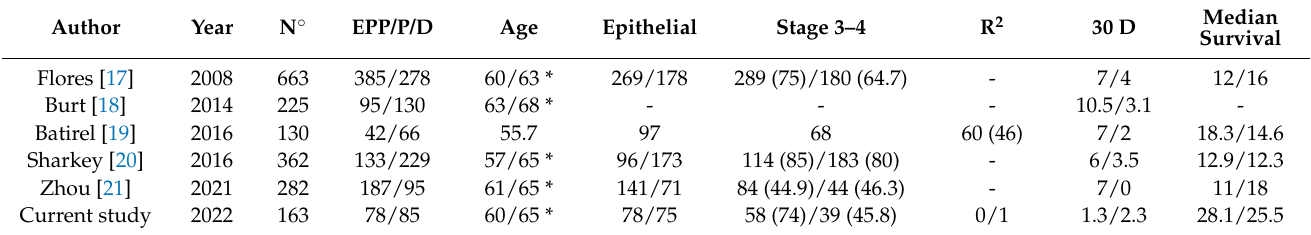
Table 5. Retrospective comparison of the results of EPP and